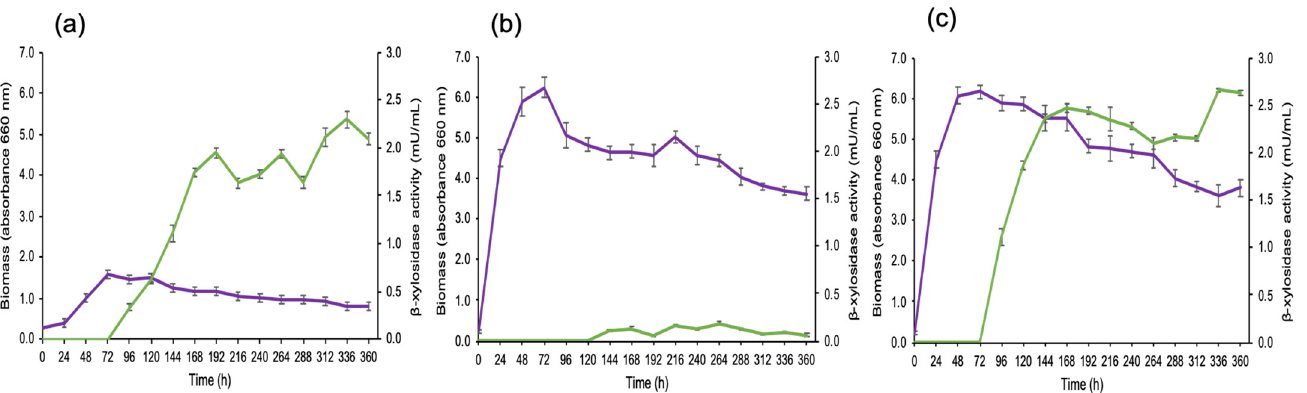
Figure 1. β -xylosidase production from S. reilianum in different culture media. ( a ) Minimum medium with glucose; ( b ) minimum medium with corn hemicellulose; and ( c ) minimum medium with corn hemicellulose and glucose. Green line: biomass determined by the increase in the absorbance at 660 nm. Purple line: β -xylosidase